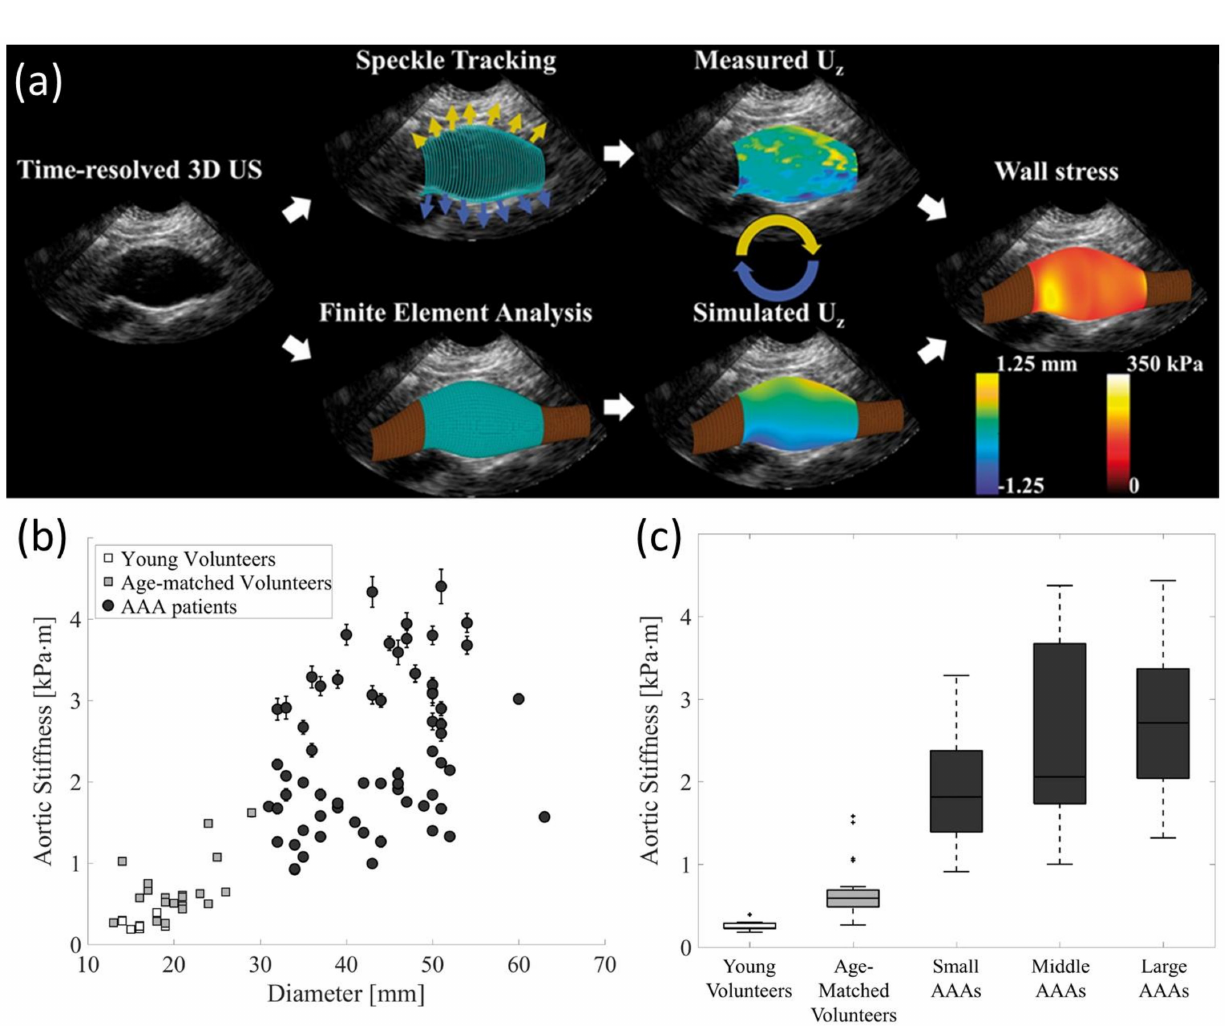
Figure 14. Inverse analysis of abdominal aneurysm mechanics (Reprinted/adapted with permission from Ref. [283]. 2018, Oxford University Press). ( a ) Patient-specific data processing algorithm and typical outputs. ( b ) Aortic stiffness versus maximum aortic diameter for healthy volunteers (gray squares) and AAA patients (black circles). ( c ) Population-based statistics of aortic stiffness in a box and whisker plot with dots representing outliers. Results suggest that most wall stiffening occurs at early stages of the disease when the aneurysm diameter is still relatively